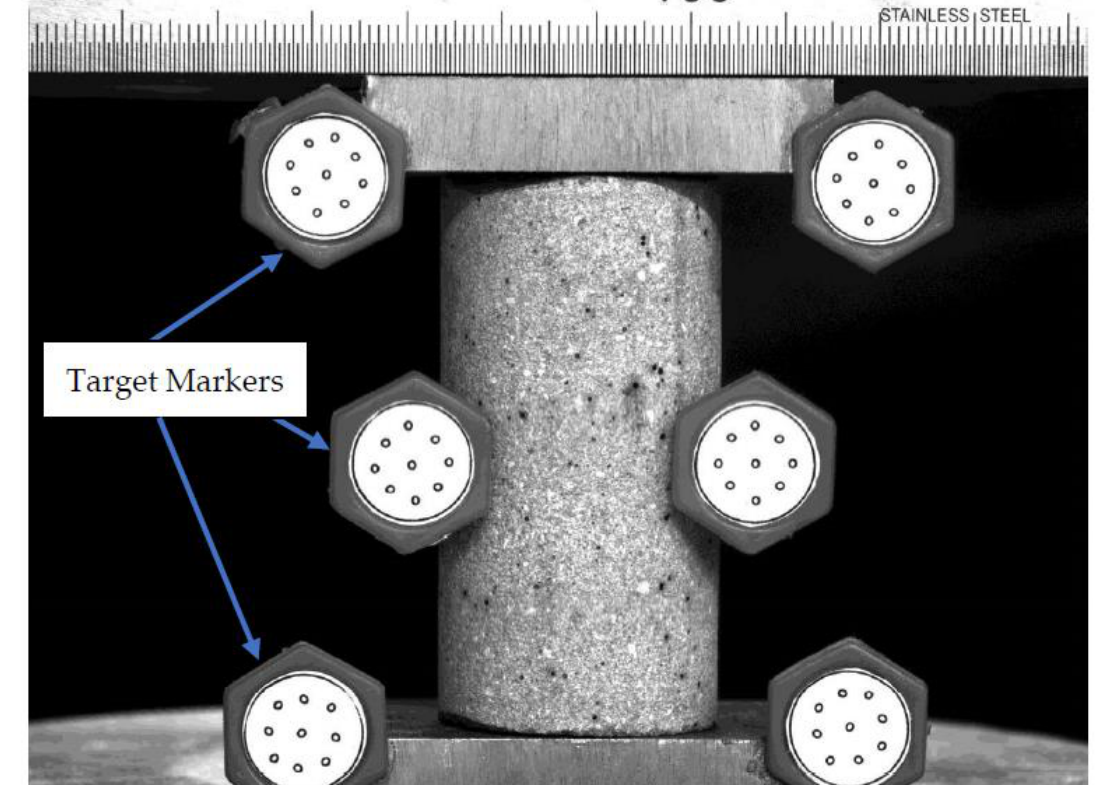
Figure 6. A DIC monochrome image of an assembled test specimen containing six target markers, with nine point-components each. Four target markers (two below top platen and two above bottom platen) track longitudinal strain while two target markers placed laterally at specimen mid-height track lateral strain. A ruler with 10 mm increments is placed above the specimen to calibrate the acquired strains.